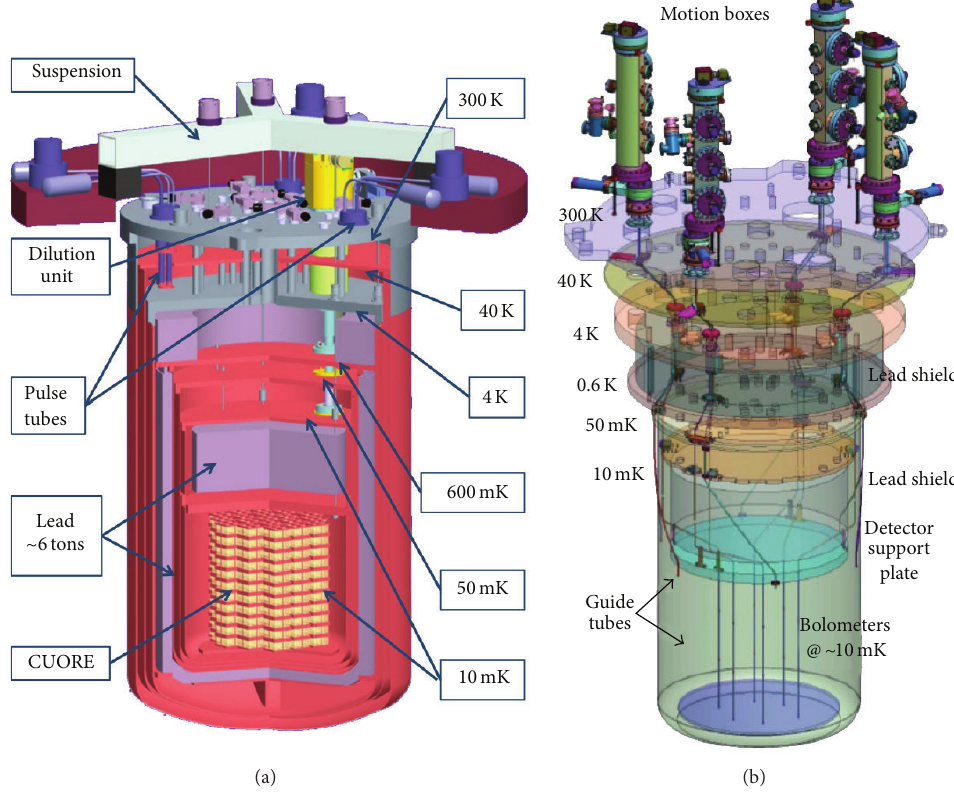
Figure 7: (a) CUORE cryostat, with major components highlighted. (b) Detector calibration system